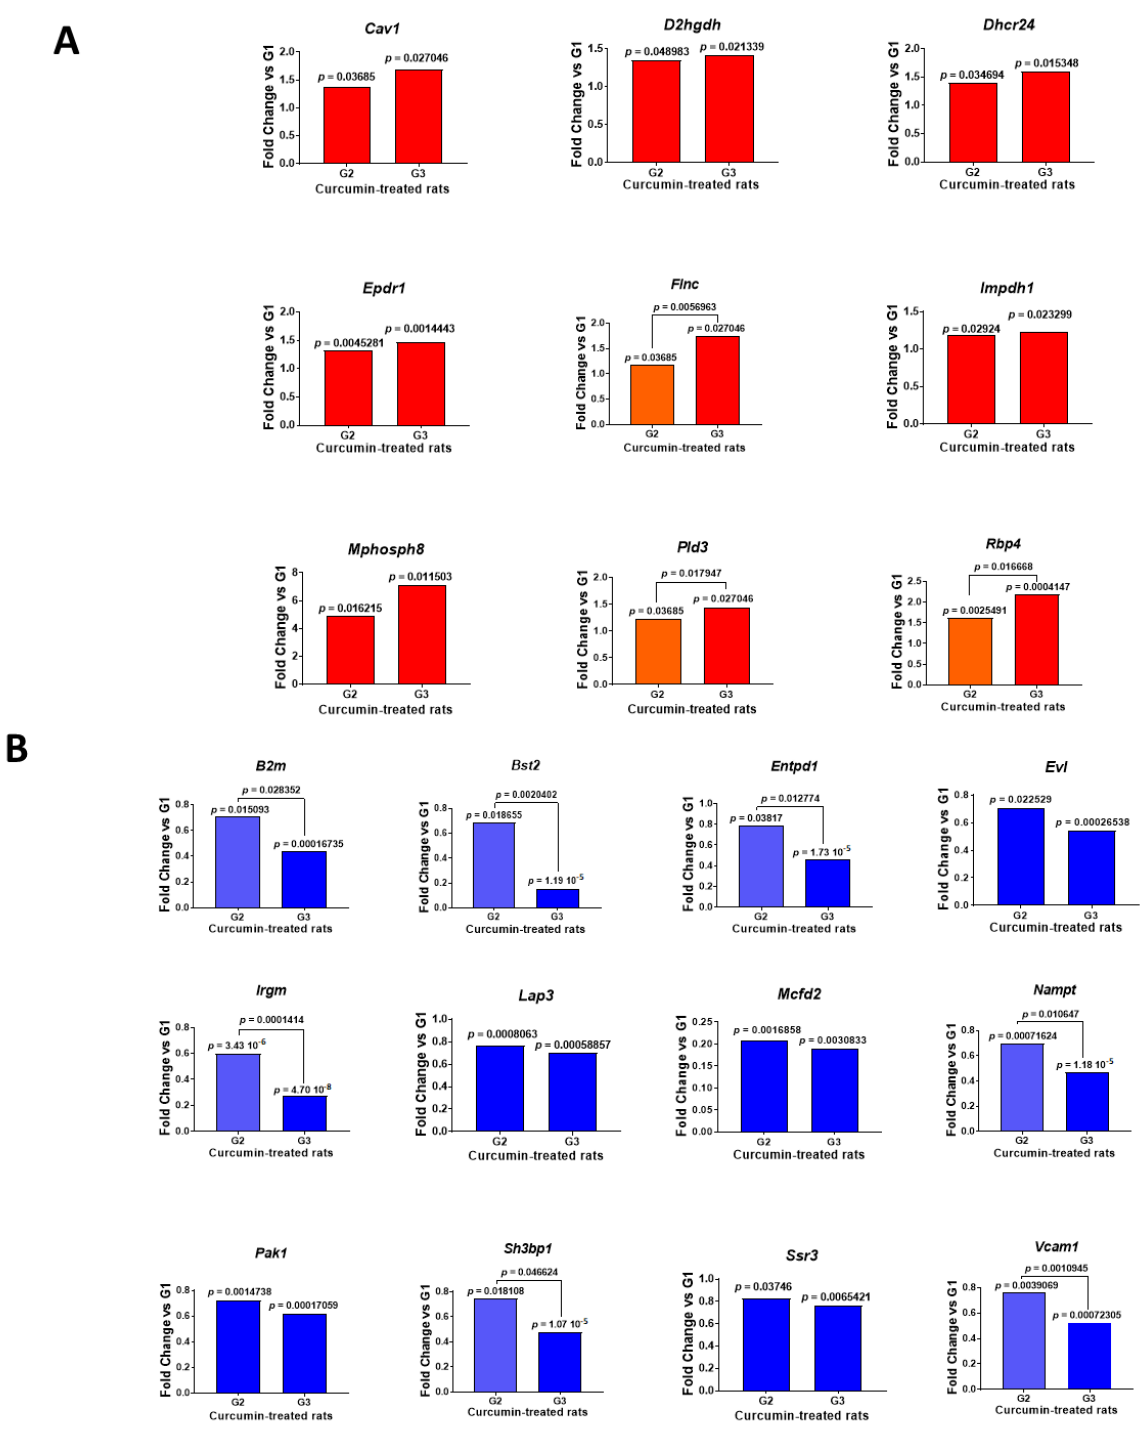
Figure 3. Evolution of abundance changes in the main proteins already documented in the literature. ( A ): increase. ( B ): decrease. The results are expressed as fold changes for G2 or G3 vs. G1, with p values observed for G2 vs. G1 and/or G3 vs. G1 indicated at the top of the bars. When the differences between G3 vs. G2 were also significant, corresponding p values were also included.